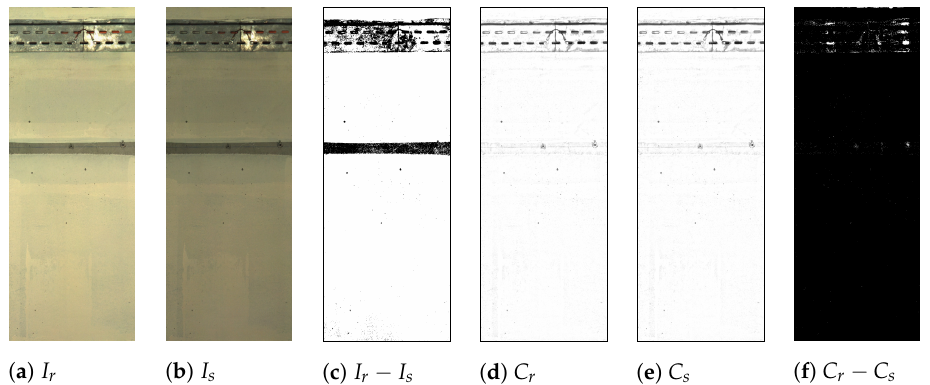
Figure 4. The original reference I r ( a ) and survey I s ( b ) images, the difference image ( c ), the pre- processed reference C r ( d ) and survey C s ( e ) images, and the difference image of the pre-processed images ( f ).